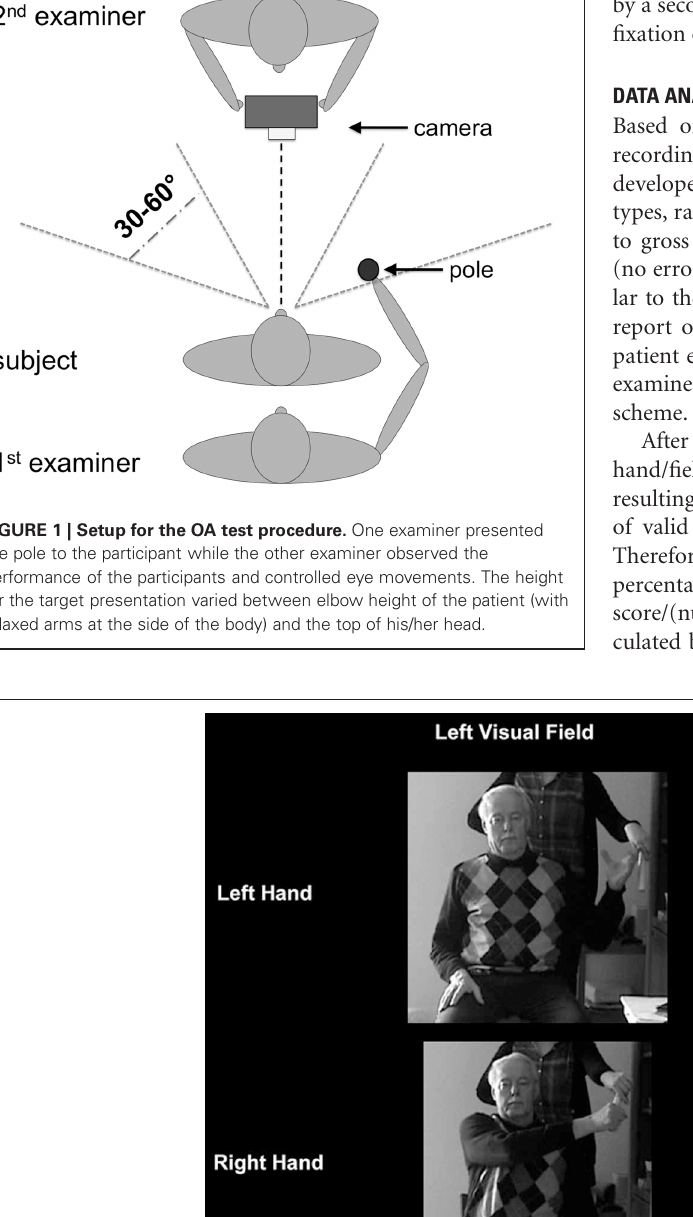
Frontiers in Human